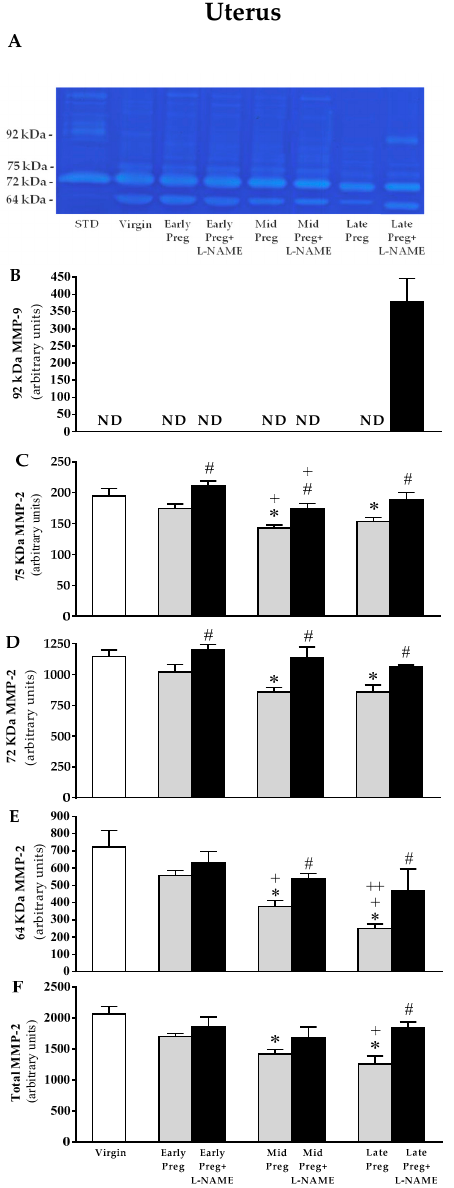
Figure 5. Representative zymography gel from the uterus ( A ). Gelatinolytic activity of 92 KDa mmP-9 was only detected in Late-Perg + LNAME group ( B ), and, 75 KDa mmP-2 ( C ), 72 KDa mmP-2 ( D ), 64 KDa mmP-2 ( E ), and total mmP-2 ( F ) in virgin rats and Early, middle (Mid), and Late-pregnant rats treated with saline or L-NAME. Values represent mean ± SEM. * P < 0.05 versus Virgin group, # P < 0.05 versus respective Early-Preg, Mid-Preg and Late-Preg groups, + P < 0.05 versus Early-Preg group and ++ P < 0.05 versus Mid-Preg or Mid-Preg + L-NAME